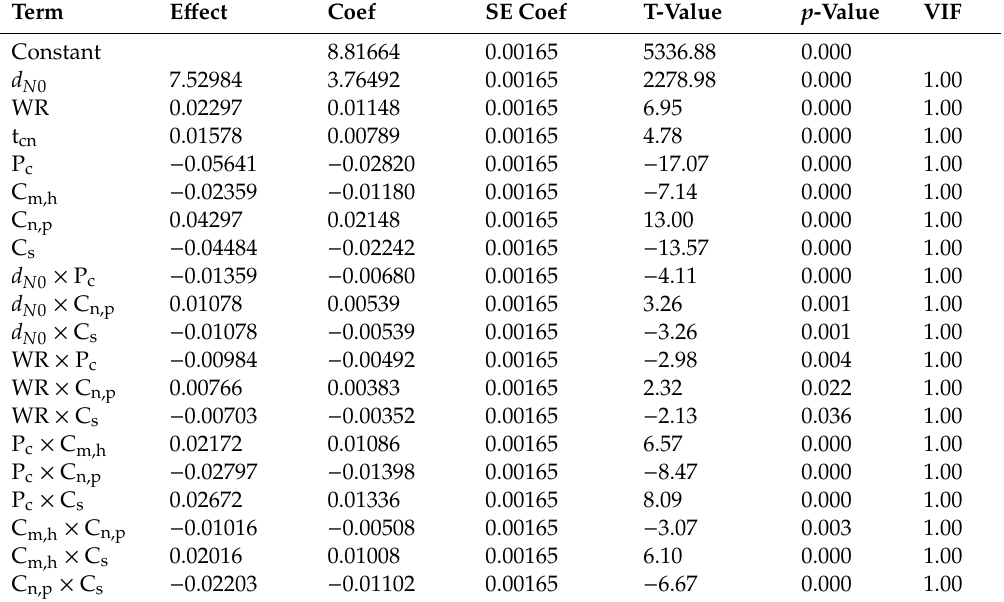
Table 3. Estimated e ff ects and coe ffi cients for d op